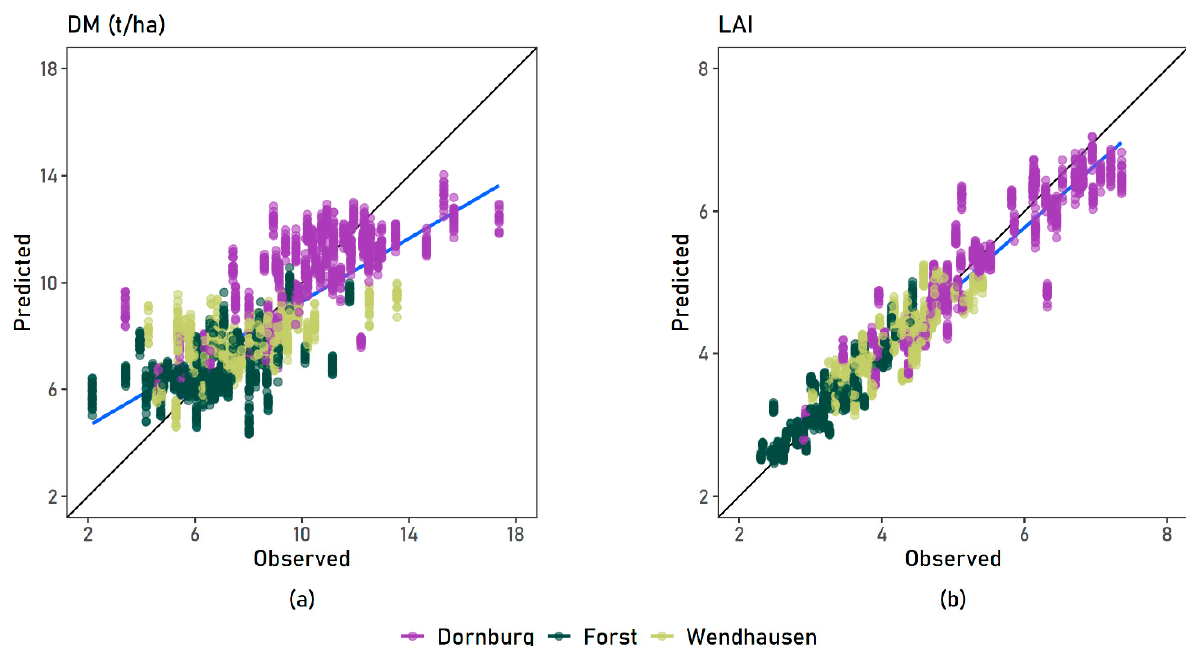
Figure 4. Observed versus predicted values for ( a ) DM and ( b ) LAI at each sampling site. Values from all sites were included in the model, represented by different colors. Blue line is the regression line, black line is 1:1 line.